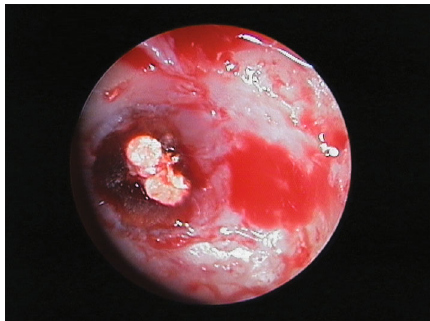
Figure 8: Endoscopic view of 1.1 before removal of the old fi ller material.